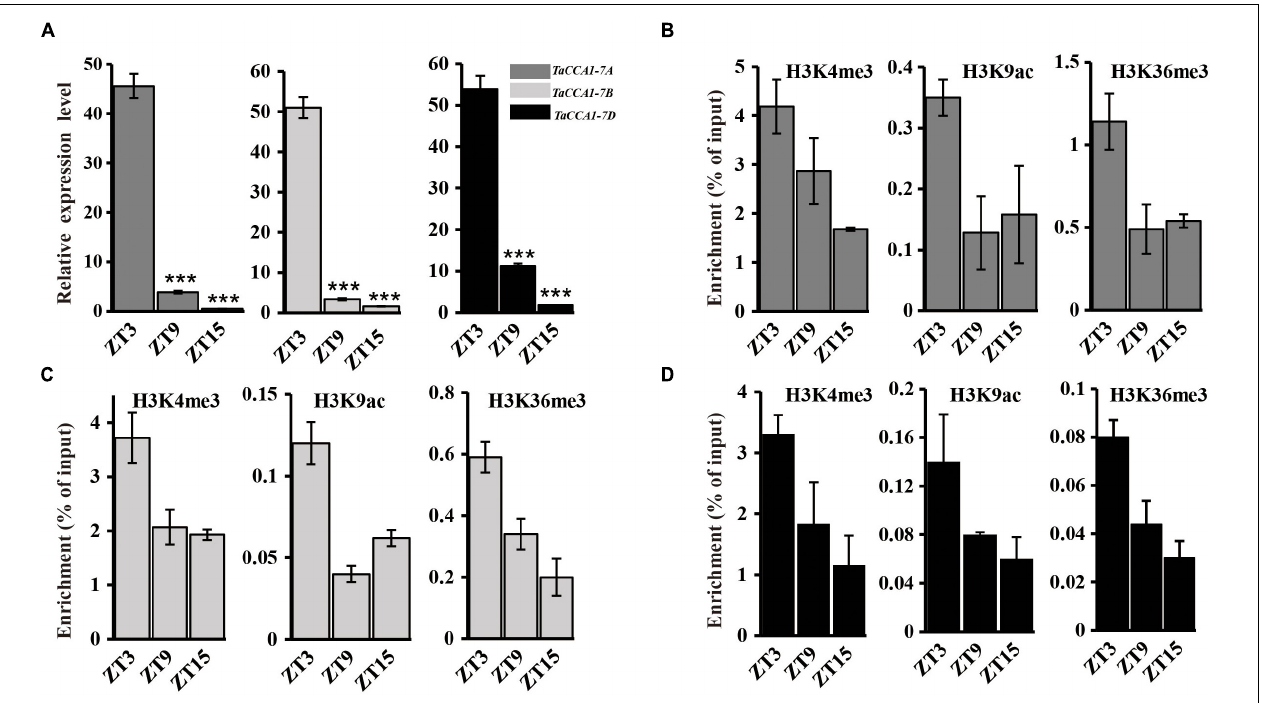
FIGURE 2 | Chromatin regulation of TaCCA1 homoeologs. (A) qPCR analysis the expression of TaCCA1 homoeologs at ZT3, ZT9, and ZT15. Values are means ± SD ( n = 3). Asterisks indicate significant differences of gene expression between ZT3 and ZT9, ZT15 using Student’s t -test (*** P < 0.001). (B–D) ChIP-PCR analysis of TaCCA1-7A , TaCCA1-7B, and TaCCA1-7D promoter at ZT3, ZT9, and ZT15 using antibodies (Ab) against H3K4me3, H3K9Ac, and H3K36me3 in wheat line 73064-1. Values are means ± SD ( n =